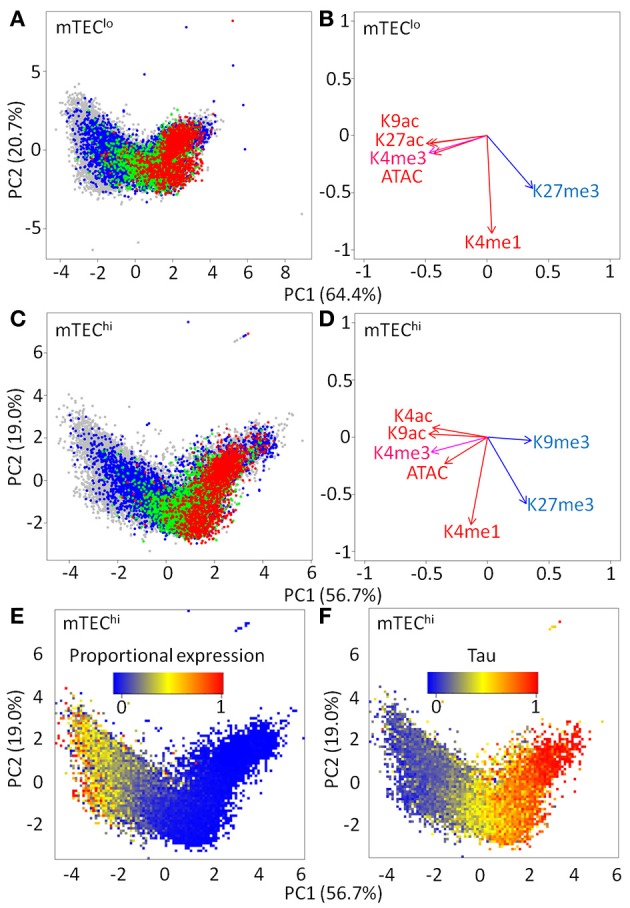
Principal component analysis (PCA) of chromatin signatures in mTEClo and mTEChi. PCA plot of maximum signal within 1 kb of the TSS of individual genes [red = AIRE dependent; green = AIRE enhanced; blue = AIRE independent TRAs; gray = all other genes; (A) mTEClo and (C) mTEChi]. PCA rotations of individual chromatin marks for (B) mTEClo and (D) mTEChi. PCA heatmaps of genes shaded by the (E) proportion of single mTEChi expressing ≥ one molecule and (F) tau tissue specificity index.